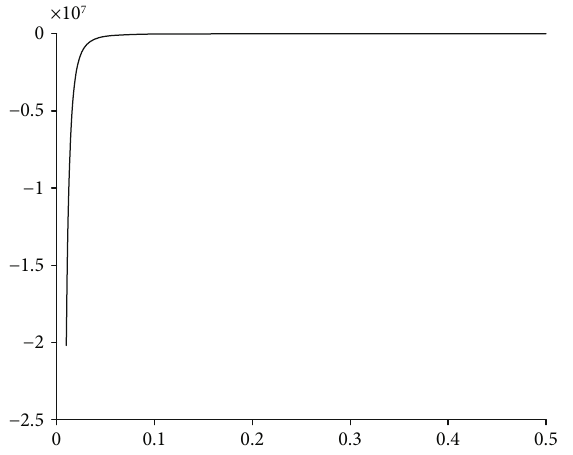
ζ Þ curve in 11 ð